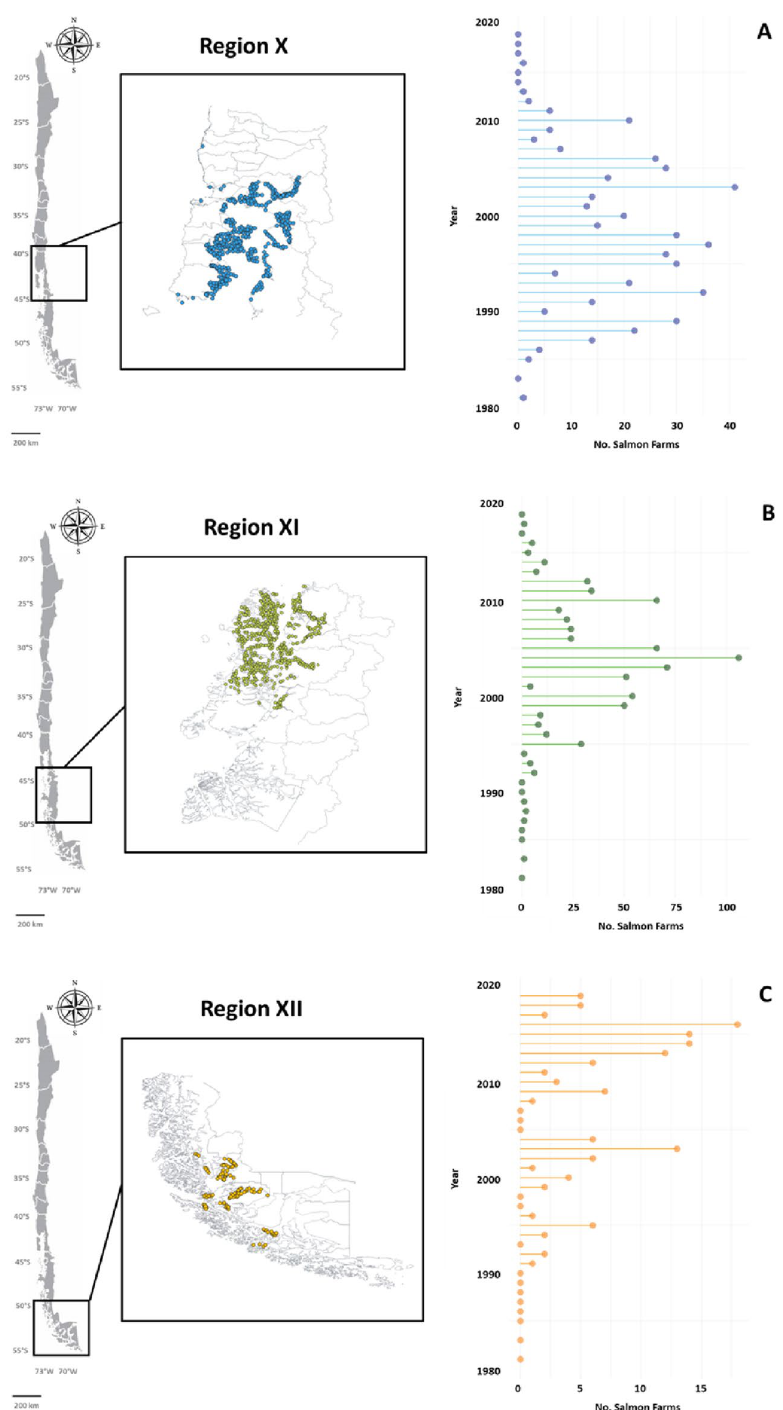
Figure 5. Spatial and temporal distribution of salmon farm concessions across Region X—Los Lagos ( A ), Region XI—Aysén del General Carlos Ibáñez del Campo ( B ), and Region XII—Magallanes y de la Antártica Chilena ( C ) over the last 38 years (1981–2019). Lollipop graphs are at different